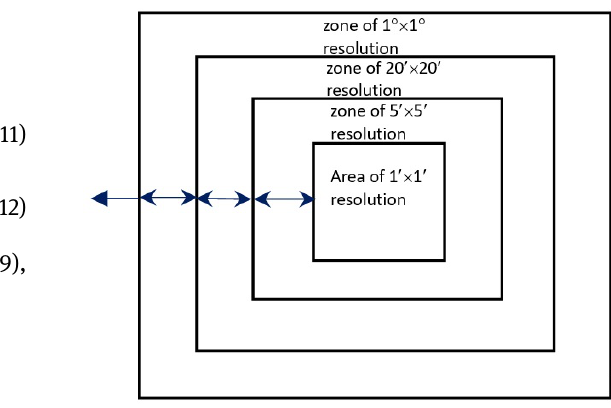
Fig. 1. Limits of the regions according to data